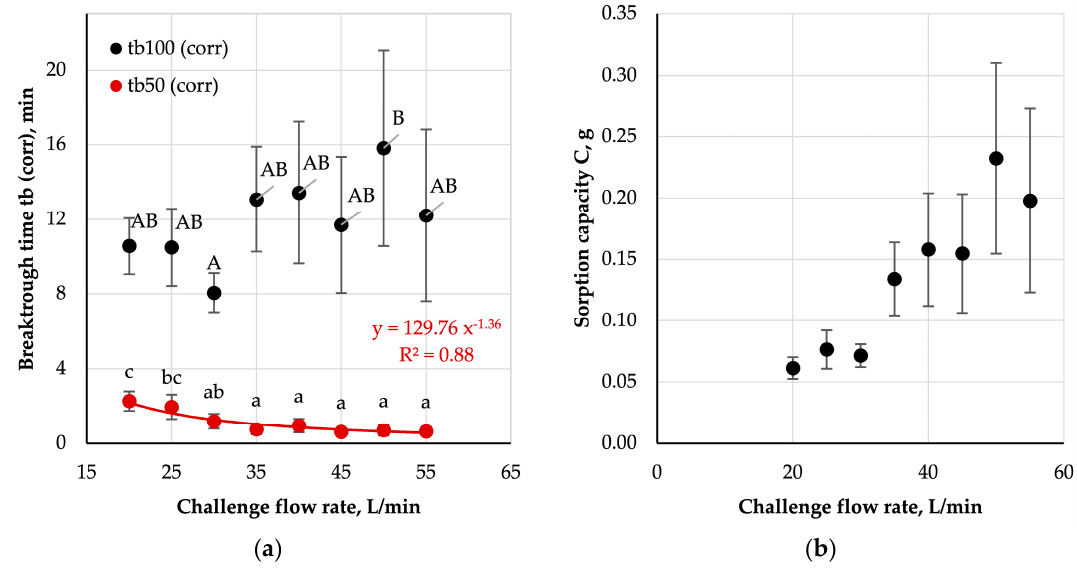
Figure 9. Influence of challenge flow rate on ( a ) corrected breakthrough time and ( b ) sorption capacity; A, B, a-c—statistically significant differences between mean values are marked with different letters; ANOVA, p < 0.05; Tukey’s test, p < 0.05.